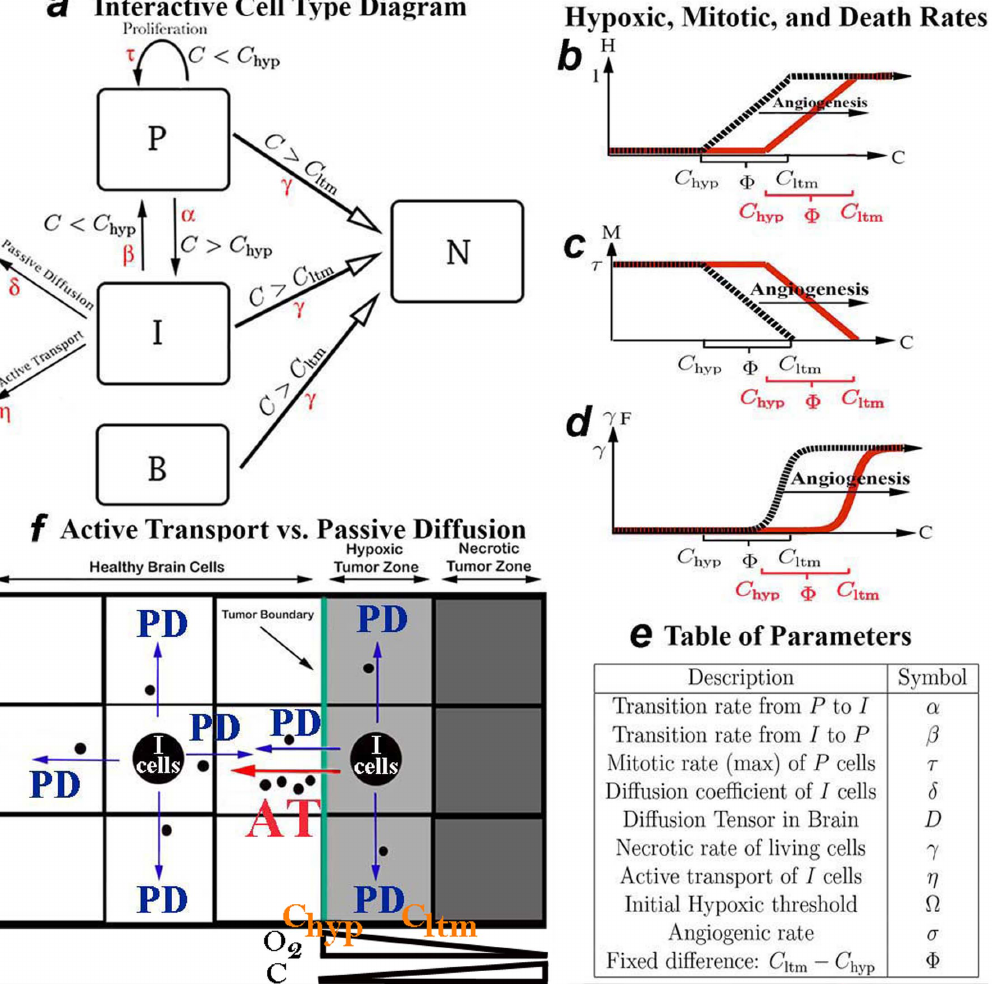
Fig. 1. Illustrative cartoons and description of the parameters. (a) Interactive Cell Type Diagram with Parameters. Parameters driving different types of cell movements or transitions are shown in red.(b) Hypoxia (H), (c) Mitotic Coefficient ( M ), and (d) Necrotic Rate ( c F ) as a function of C and angiogenesis. (e) DescriptionofModel Parameters. (f) ActiveTransport (AT) verses PassiveDiffusion(PD).AT (red arrow) actively drives I cellsin bulk towards normal healthy brain. AT does notoccur once thecellsreach a new region of healthybrain cells asthe concentration of these cells is now uniform ( i.e. thegradient ofB iszero). PD (blue arrows) allows theIcellstodiffusedowntheirconcentrationgradientequally inall directions other thanthenecrotic zone.Themodelassumes that thelocaloxygen concentration is inversely related to C ~ P z I z B z N ; furthermore, C w C hyp causes the phenotypic switch P ? I while C w C ltm w C hyp activates rapid